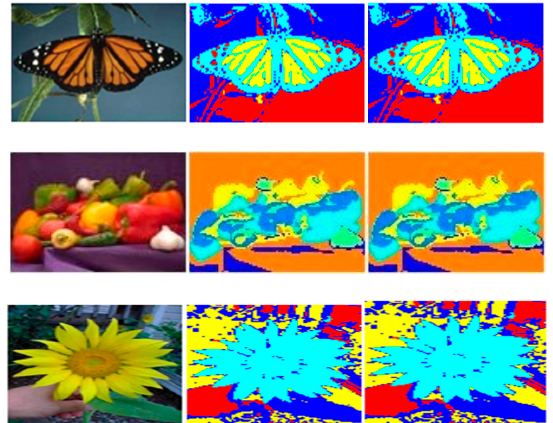
Figure 10. Left to right: original image, result of proposed implementation of PAM, result of K- Medoids clustering algorithm [17] (SSIM = 1, for all cases).